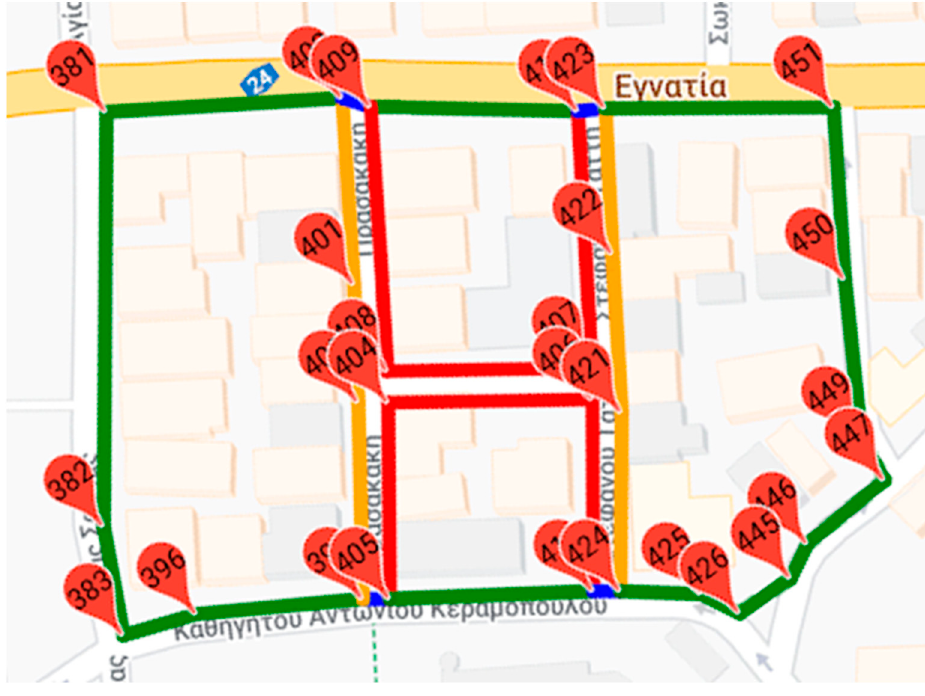
Figure 6. Use case III graph dataset.